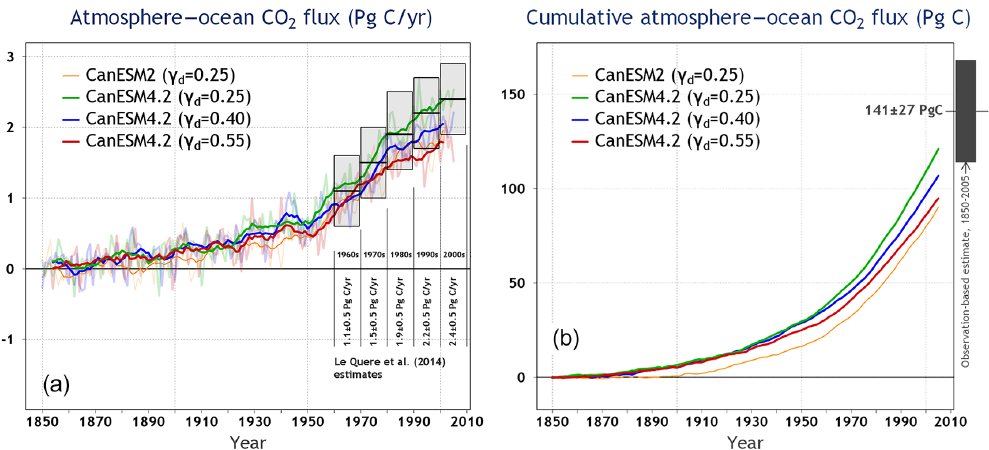
Figure 8. Atmosphere–ocean CO 2 flux ( F O ) (a) and its cumulative values e F O (b) from CanESM2 and the three CanESM4.2 historical 1850–2005 simulations for three different strengths of the terrestrial CO 2 fertilization effect. In (a) the observation-based estimates of F O and their uncertainty (show via boxes) for the decades of 1960, 1970, 1980, 1990, and 2000 are reproduced from Le Quéré et al. (2015). The bold lines in (a) are the 10-year moving averages of the annual F L values, which are shown in light colours. The results from CanESM2 and CanESM4.2 are the average of the two ensemble